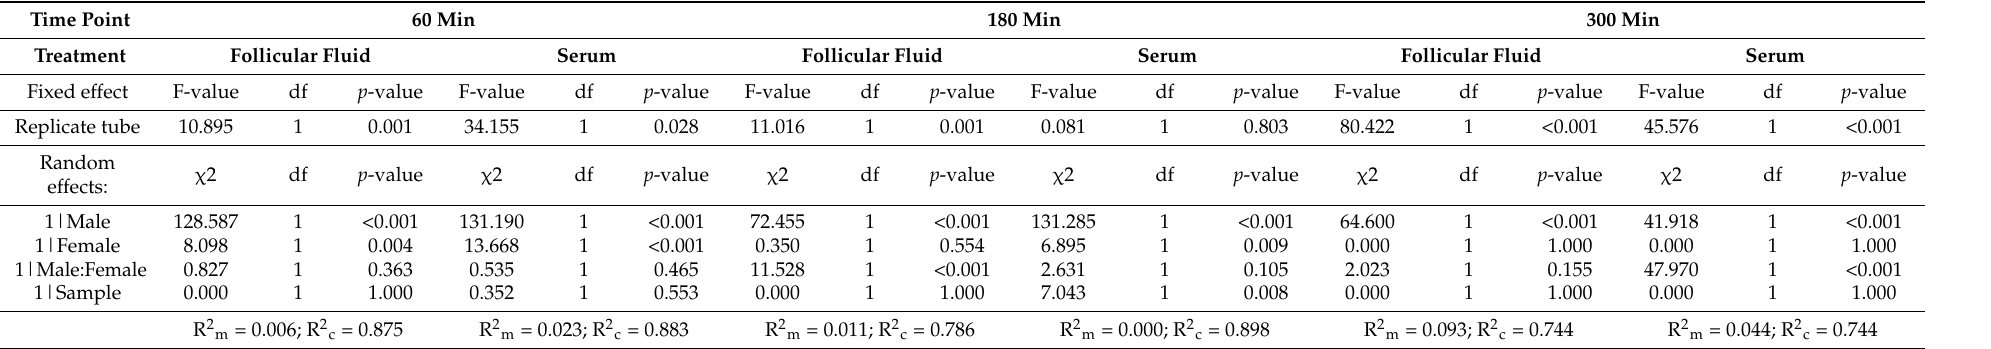
Table 1. Treatment-specific linear mixed models (LMM) for sperm swimming velocity (VCL) in each of the three time points. Models included replicate tube as fixed effect and male, female, male:female interaction, and repeated measurement of each tube (sample) as random effects. R 2 m: marginal R 2 —proportion of variance explained by fixed factors; R 2 c: conditional R 2 —proportion of variance explained by fixed and random